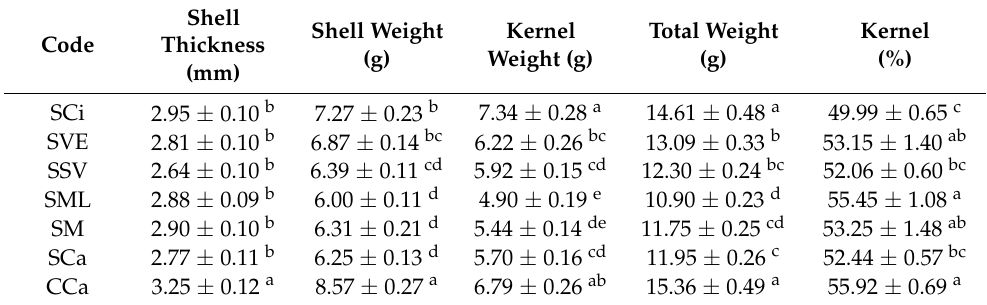
Table 3. Biometric characterization of walnuts ( n = 30).